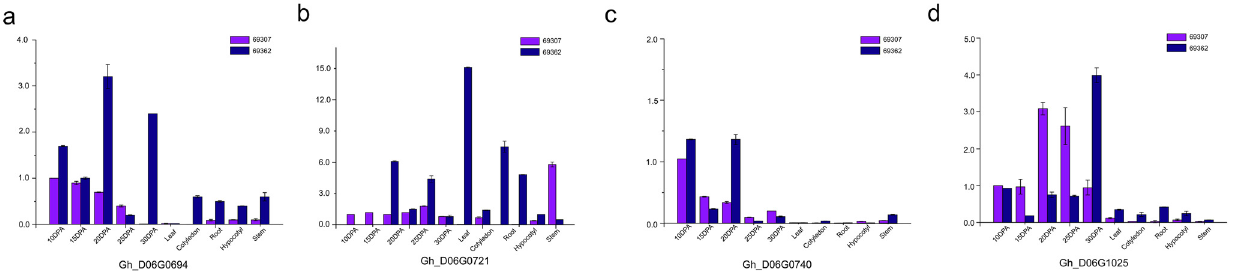
Fig 5. Expressions of candidate genes Gh_D06G0694, Gh_D06G0721, Gh_D06G0740 and Gh_D06G1025. a: Expression of Gh_D06G0694; b: Expression of Gh_D06G0721; c: Expression of Gh_D06G0740; d: Expression of